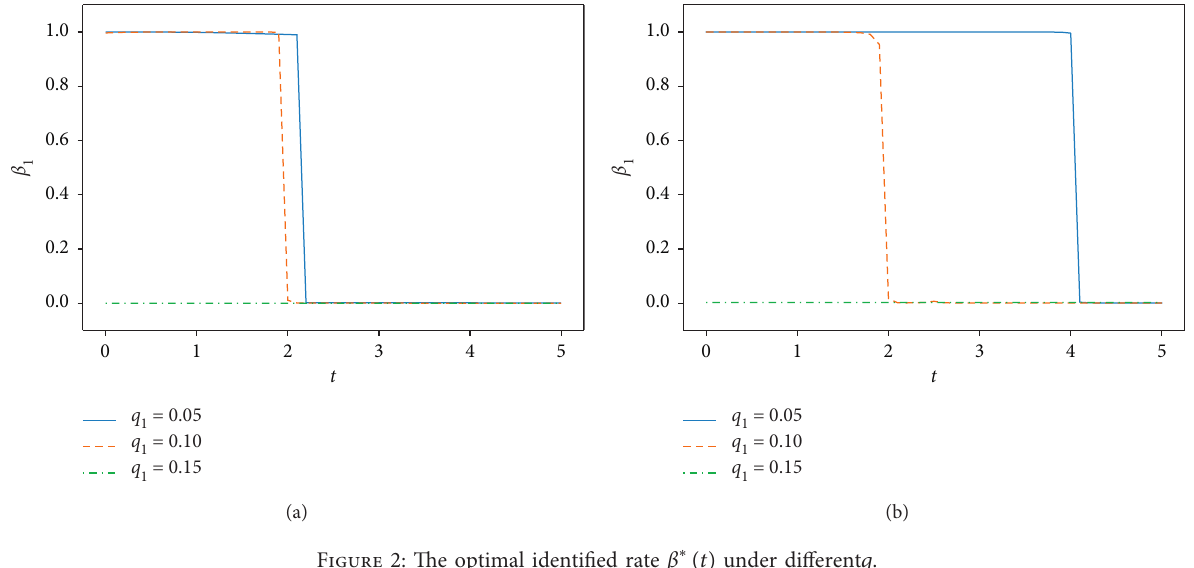
Figure 2: The optimal identified rate β ∗ ( t ) under different q .